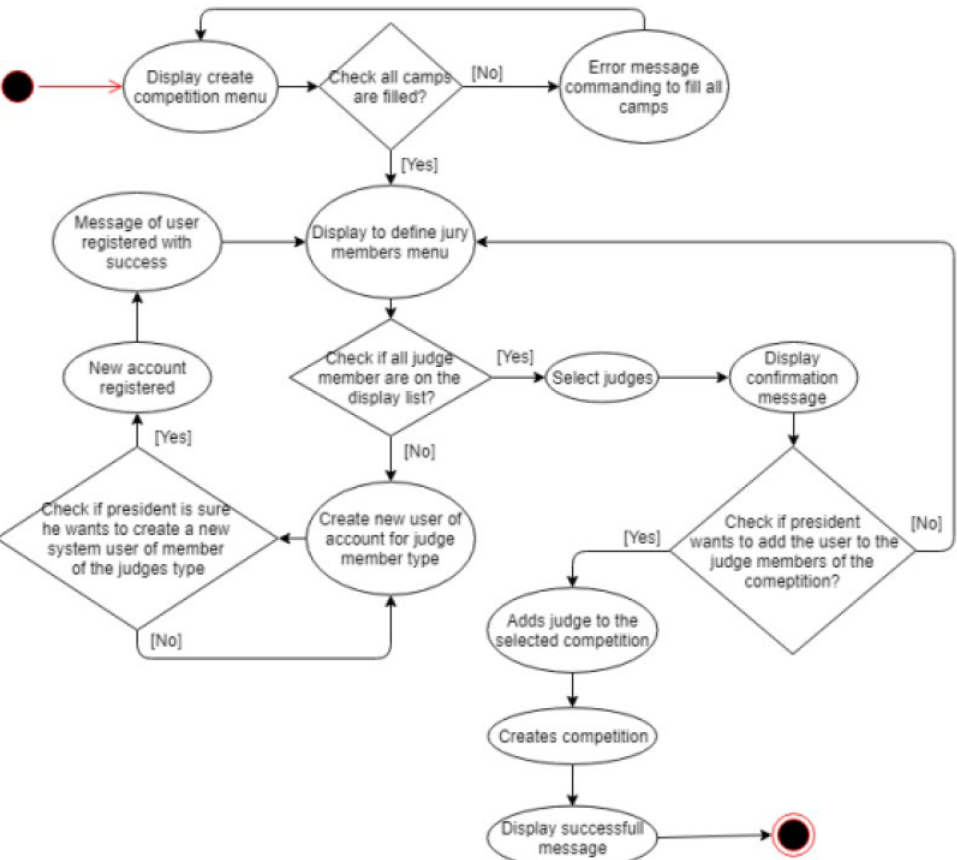
Figure 8. Activity diagram of creating a new competition